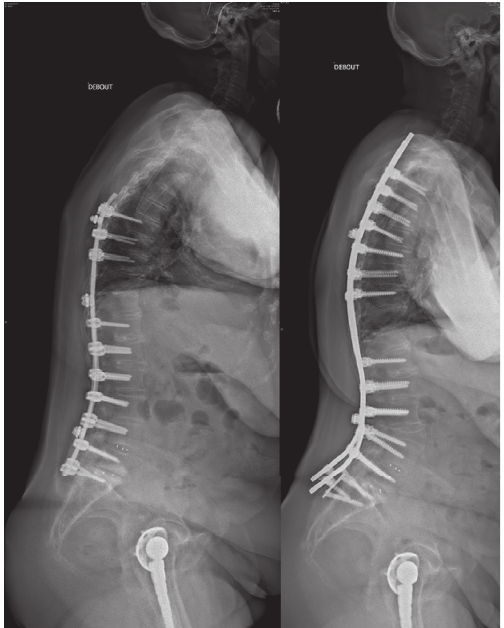
Figure 2: Clinical example of a patient form the “not aligned” group with a high PI. Revision case, T3-S2 posterior fixation, L3 grade 3 osteotomy. Preoperative measurements (left) were PI � 59 ° , PT � 34 ° , PI-LL � 32 ° , LL � − 27 ° , TK � 3 ° , and SVA � 93mm. One-year mea- surements (right) were PT � 25 ° , PI-LL � 15 ° , LL � − 44 ° , PLL �− 29 ° , DLL � − 15 ° , TK � 36 ° , and SVA �